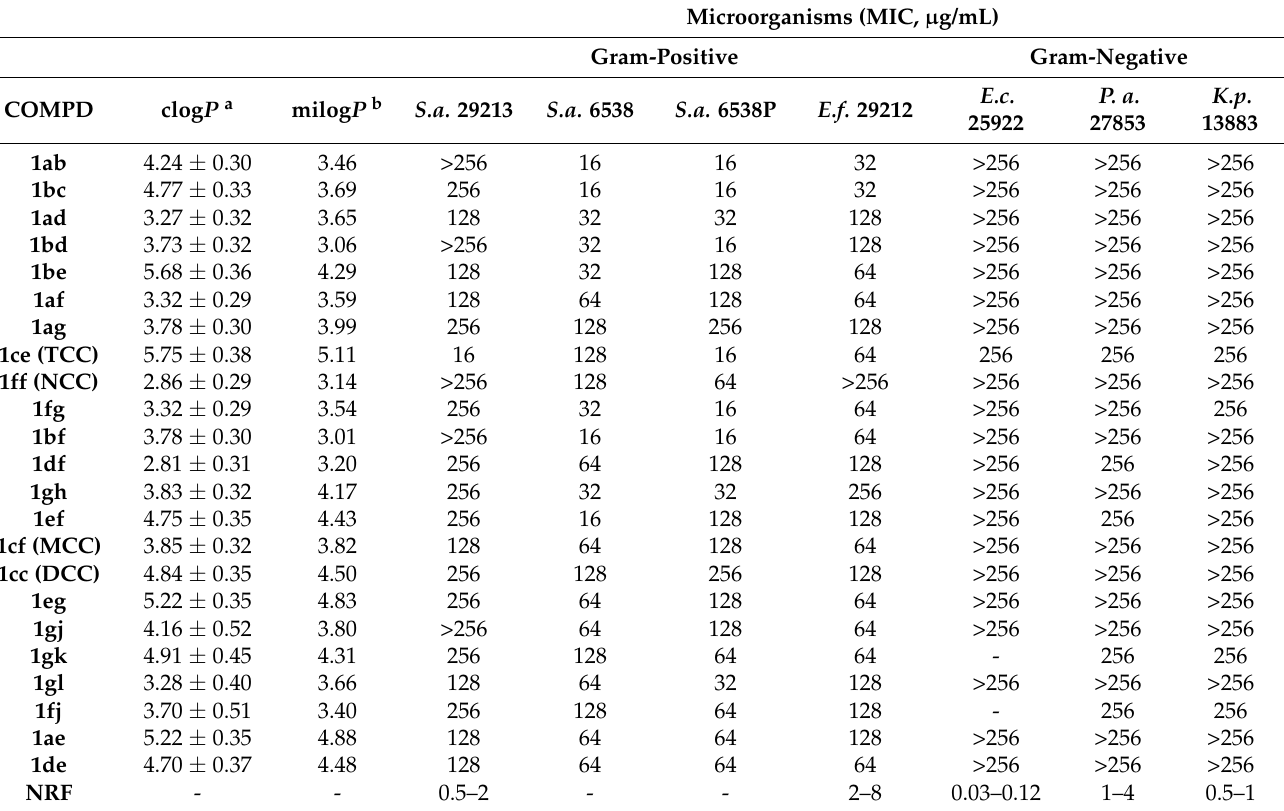
Table 1. Physicochemical properties and antibacterial activity results of